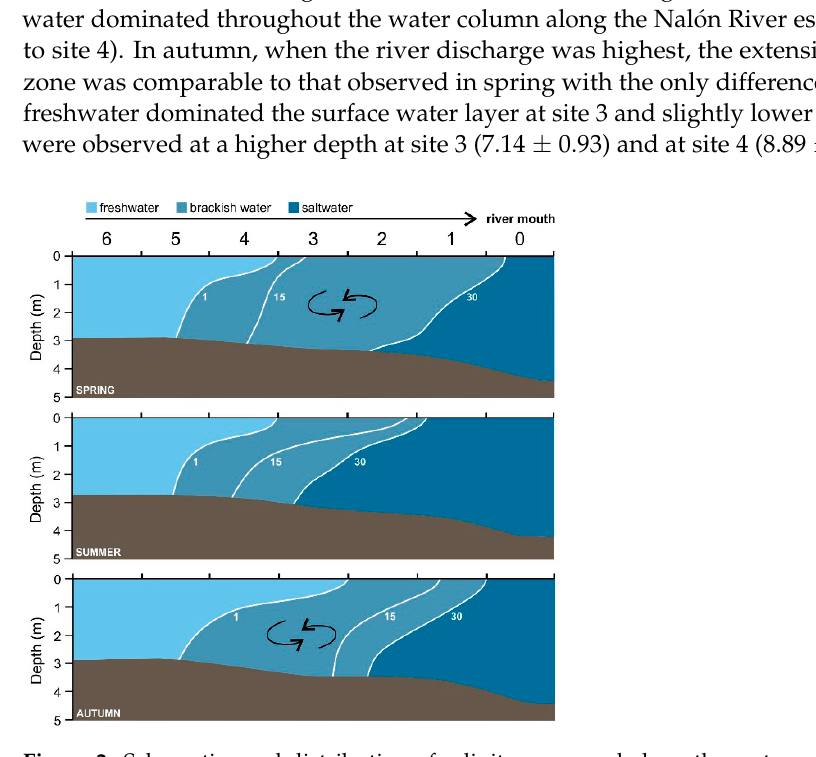
Figure 2. Schematic areal distribution of salinity measured along the water column at the seven investigated sites along the Nalón River estuary under different seasonal conditions (spring, summer, autumn).